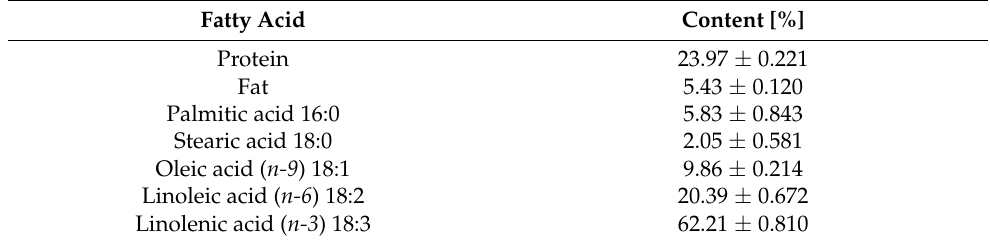
Table 2. Chemical composition of